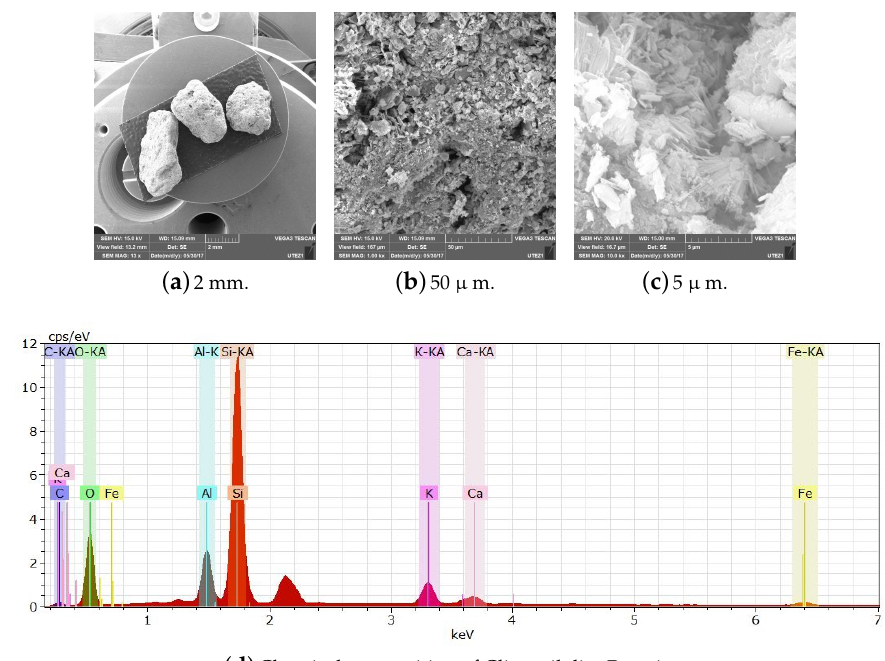
Figure A14. Scale display through SEM and chemical composition of Clinoptilolite-Potosí.